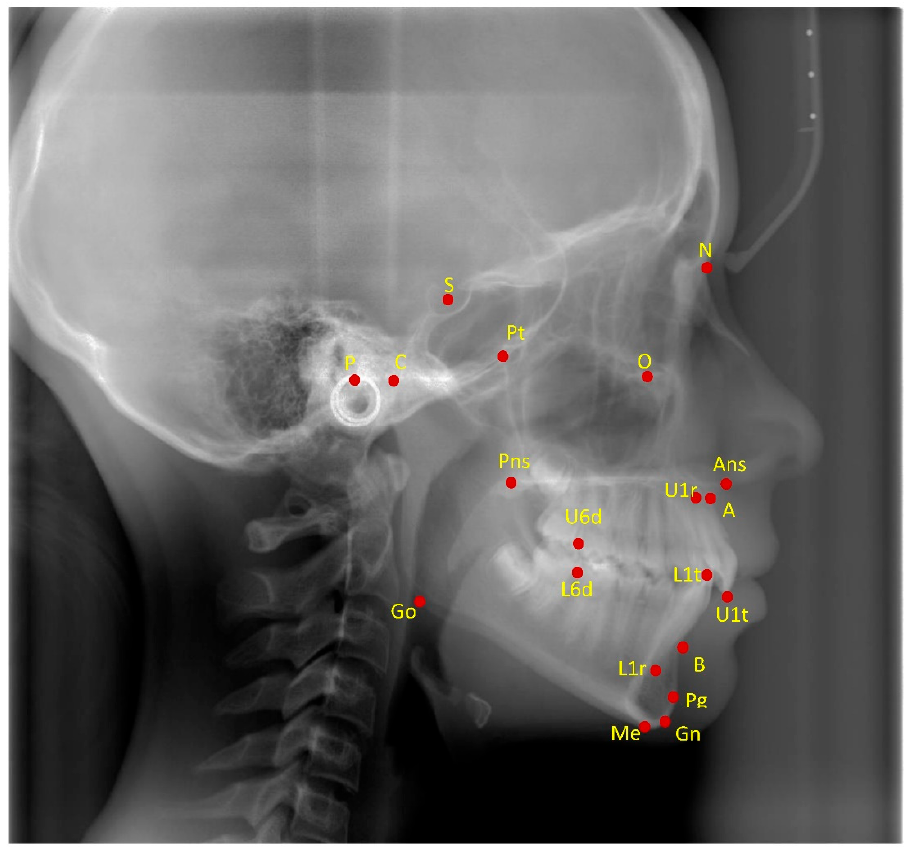
Figure 1. Cephalometric landmarks. N Nasion, S Sella, P Porion, Co Condylion, Pt Pterion, Or Orbitale, Pns Posterior nasal spine, Ans Anterior nasal spine, A Point A, B Point B, Pg Pogonion, Gn Gnathion, Me Menton, Go Gonion, U1r Root Apex Upper central incisor, U1t Tip Upper central incisor, L1r Root Apex Lower central incisor, L1t Tip Lower central incisor, U6d Distal Upper first molar, L6d Distal Lower first molar. Table 1. Analyzed cephalometric variables.